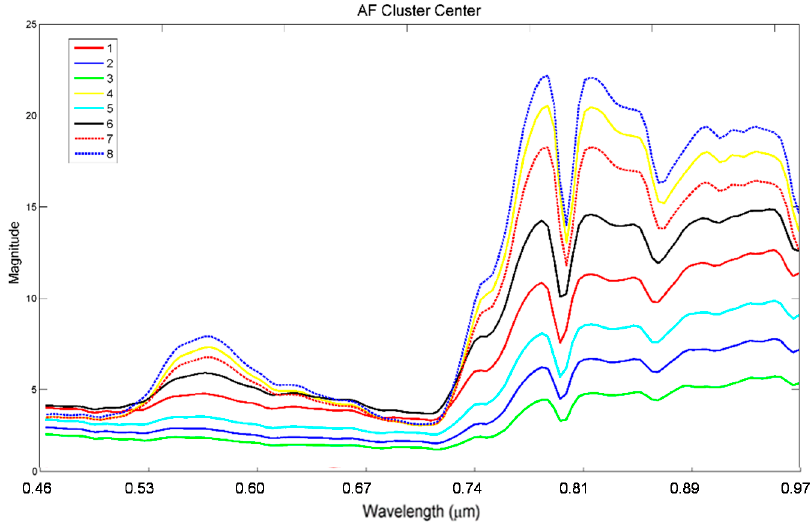
Figure 10. Spectral signatures of the eight cluster centers.